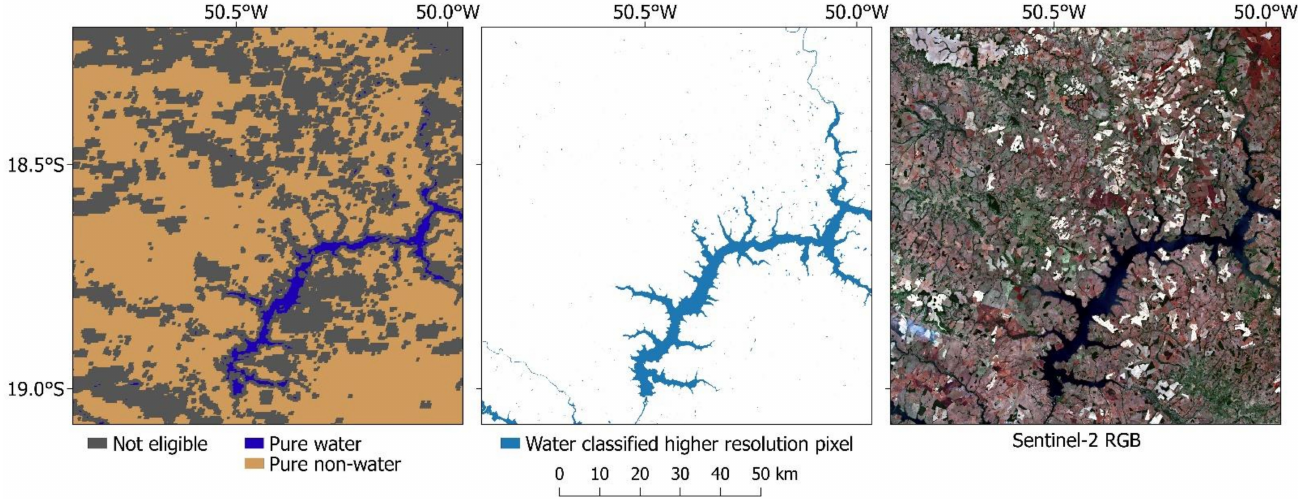
Figure 7. Selection of pure water and non-water pixels. Data: MODIS Terra tile h13v10 and Sentinel-2 tile R081 T22KEE,